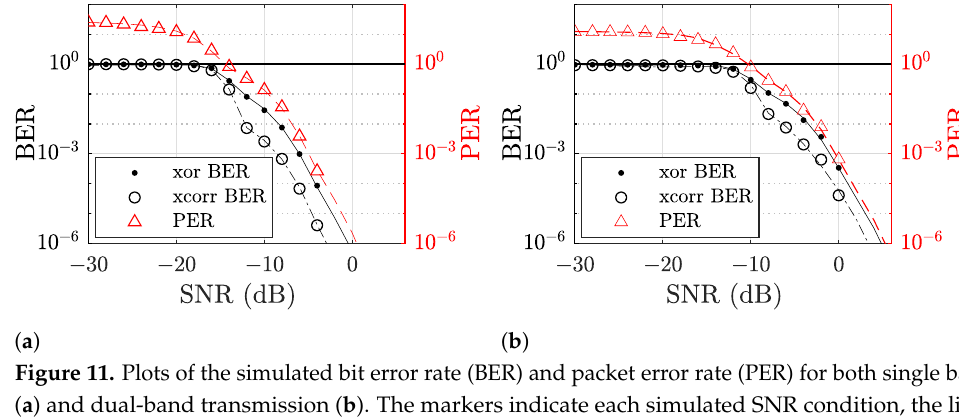
Figure 11. Plots of the simulated bit error rate (BER) and packet error rate (PER) for both single band ( a ) and dual-band transmission ( b ). The markers indicate each simulated SNR condition, the lines are manually fitted